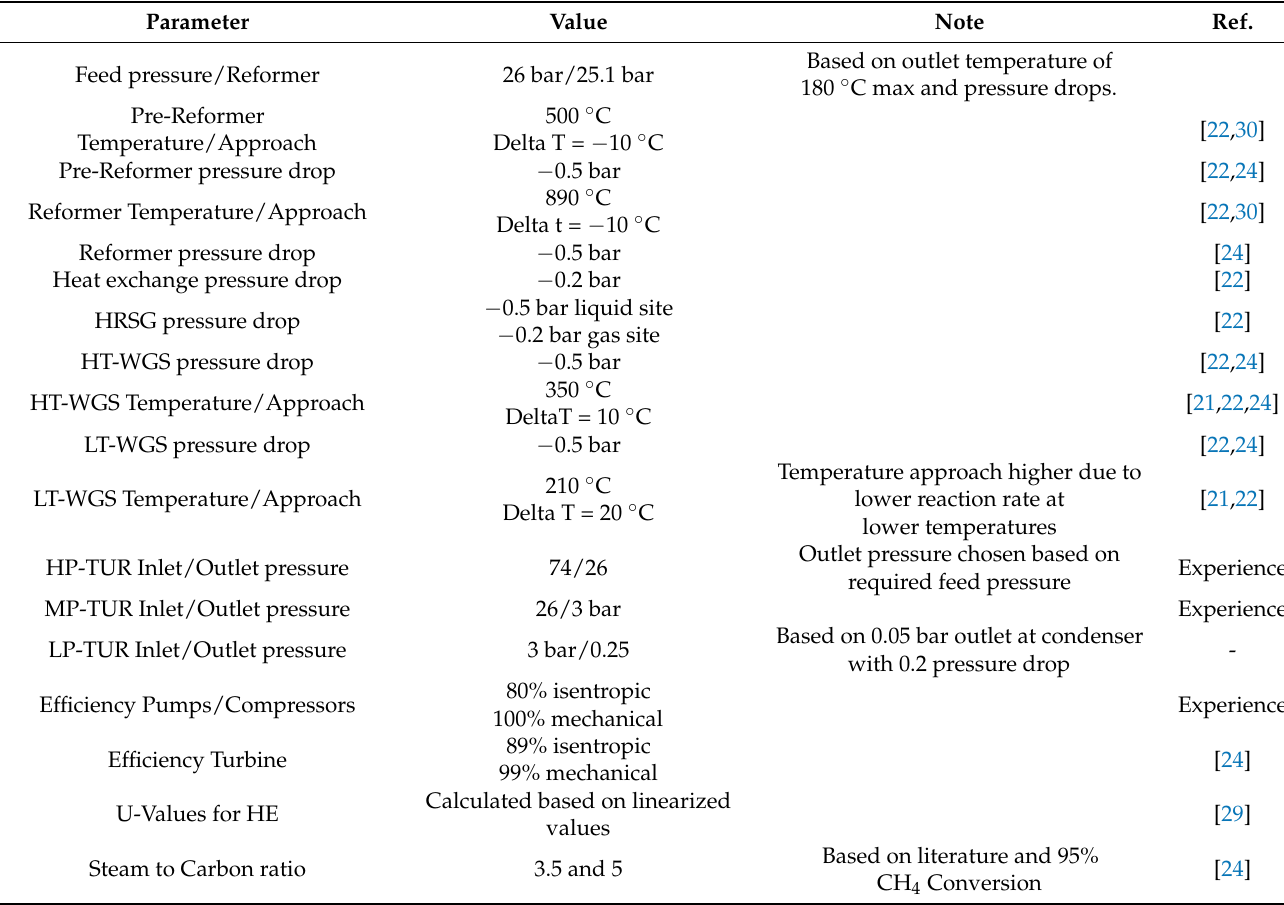
Table 2. Key modeling parameters for SMR